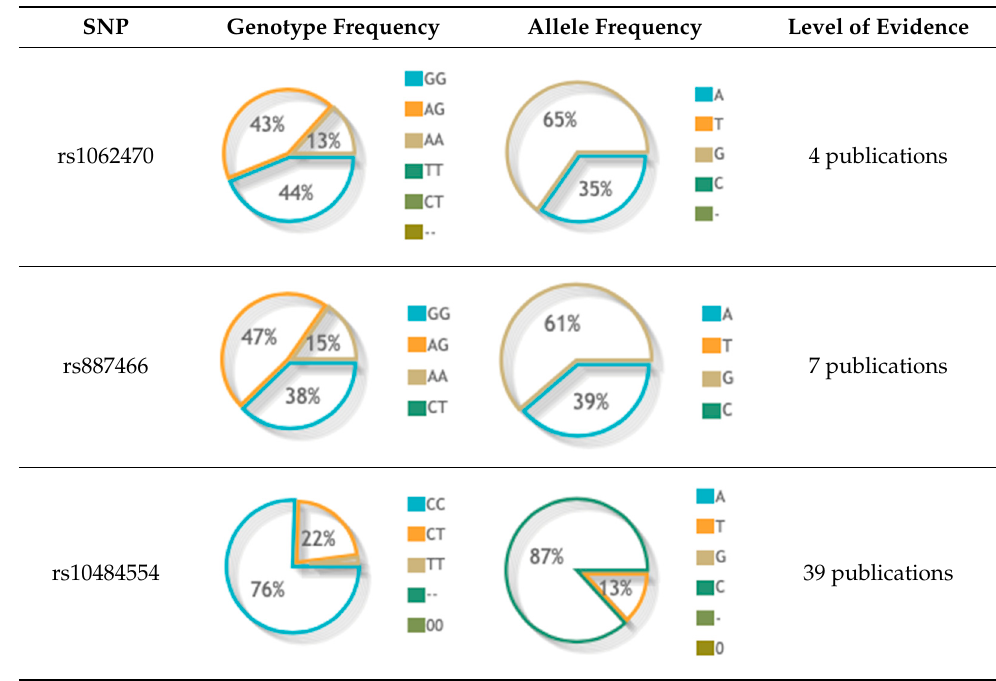
Table 7. Summary of the estimated genotype and allele frequency for each studied SNP based on worldwide previous publications (Data adopted from https://opensnp.org/ (accessed on 1 March 2022) [18]).